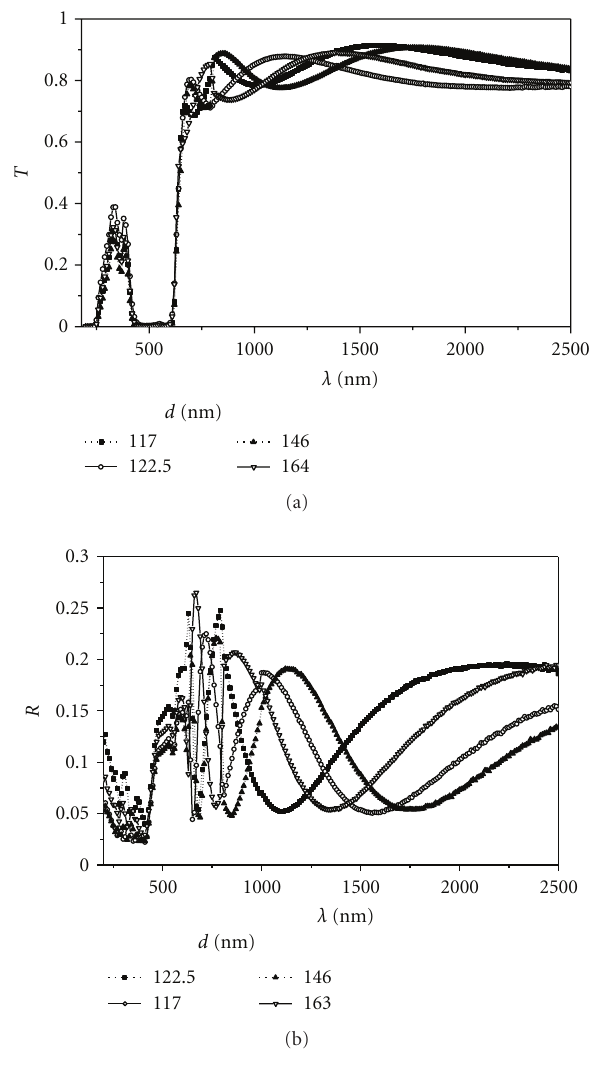
Figure 4: The spectra of the prepared PTCDI films (a) transmission and (b) reflection.